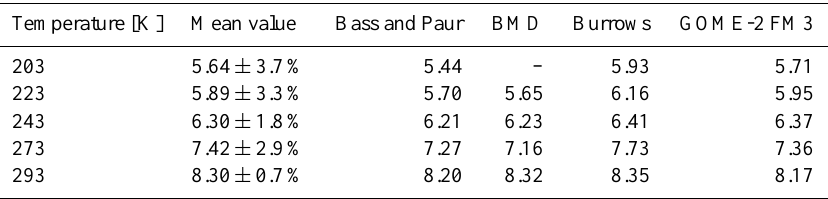
Table 4. Comparison of integrated cross sections in the Huggins band (325–340nm) in units of 10 − 20 cm 2 nmmolecule − 1 , the second column indicates the mean from all available literature (Orphal, 2002).